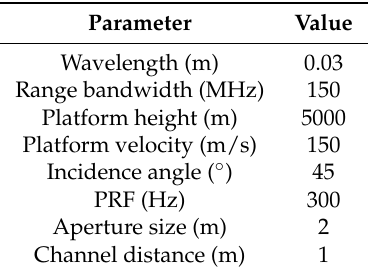
Table 1. SAR radar system parameters for